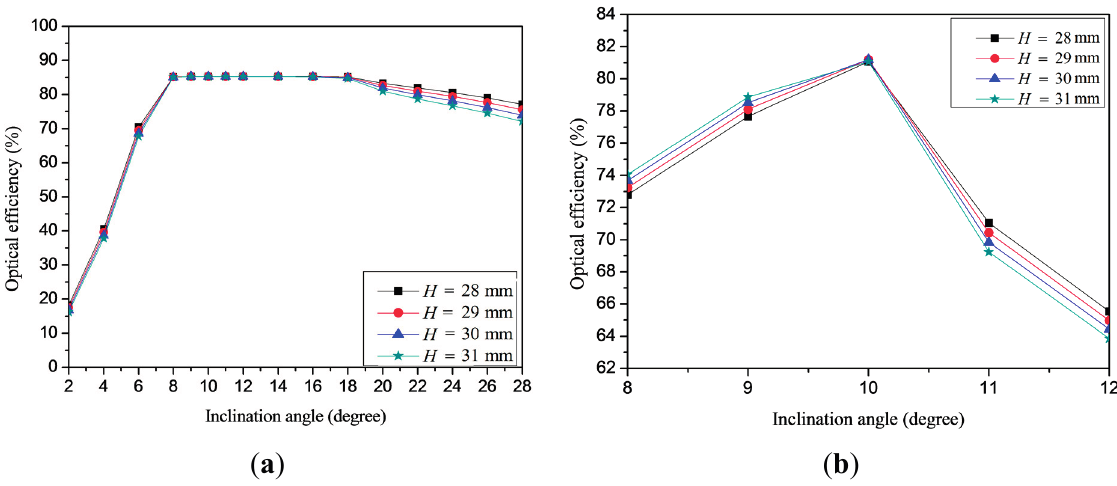
Figure 15. Optical efficiency for the Fresnel lens with KFTS-type SOE with various design values of H and θ . ( a ) under normal incidence; ( b ) incidence angle =